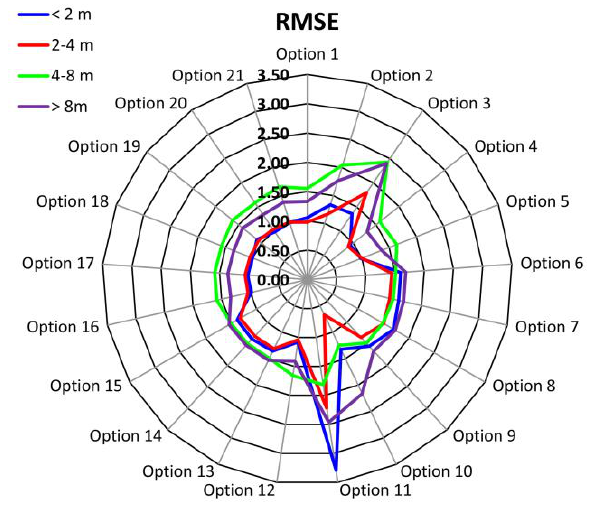
Figure 5. Computed RMSE values for all 21 model options in different depth levels